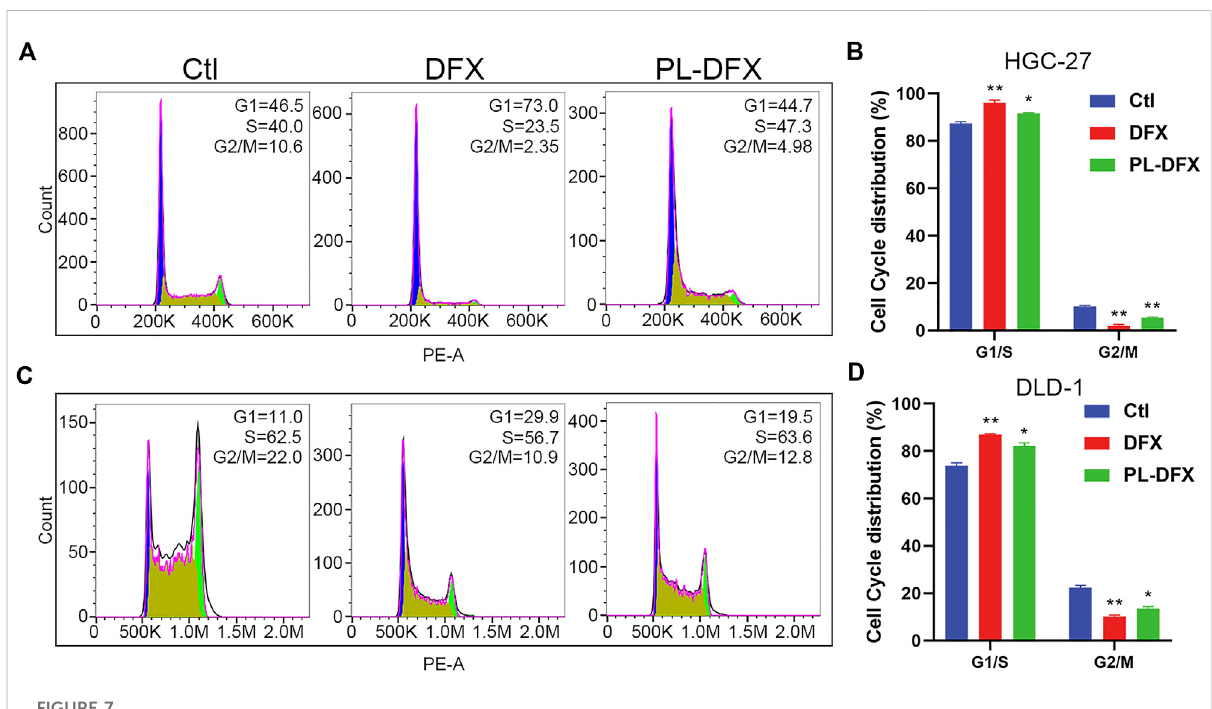
ImpactofDFXandPL-DFXoncellcycle. (A,B) CellcycledistributionofHGC-27incubatedwithDFX(25 μ M)andPL-DFX(12.5 μ M)for24 h (C,D) Cell cycle distribution of DLD-1 incubated with DFX (25 μ M) and PL-DFX (12.5 μ M) for 24 h.